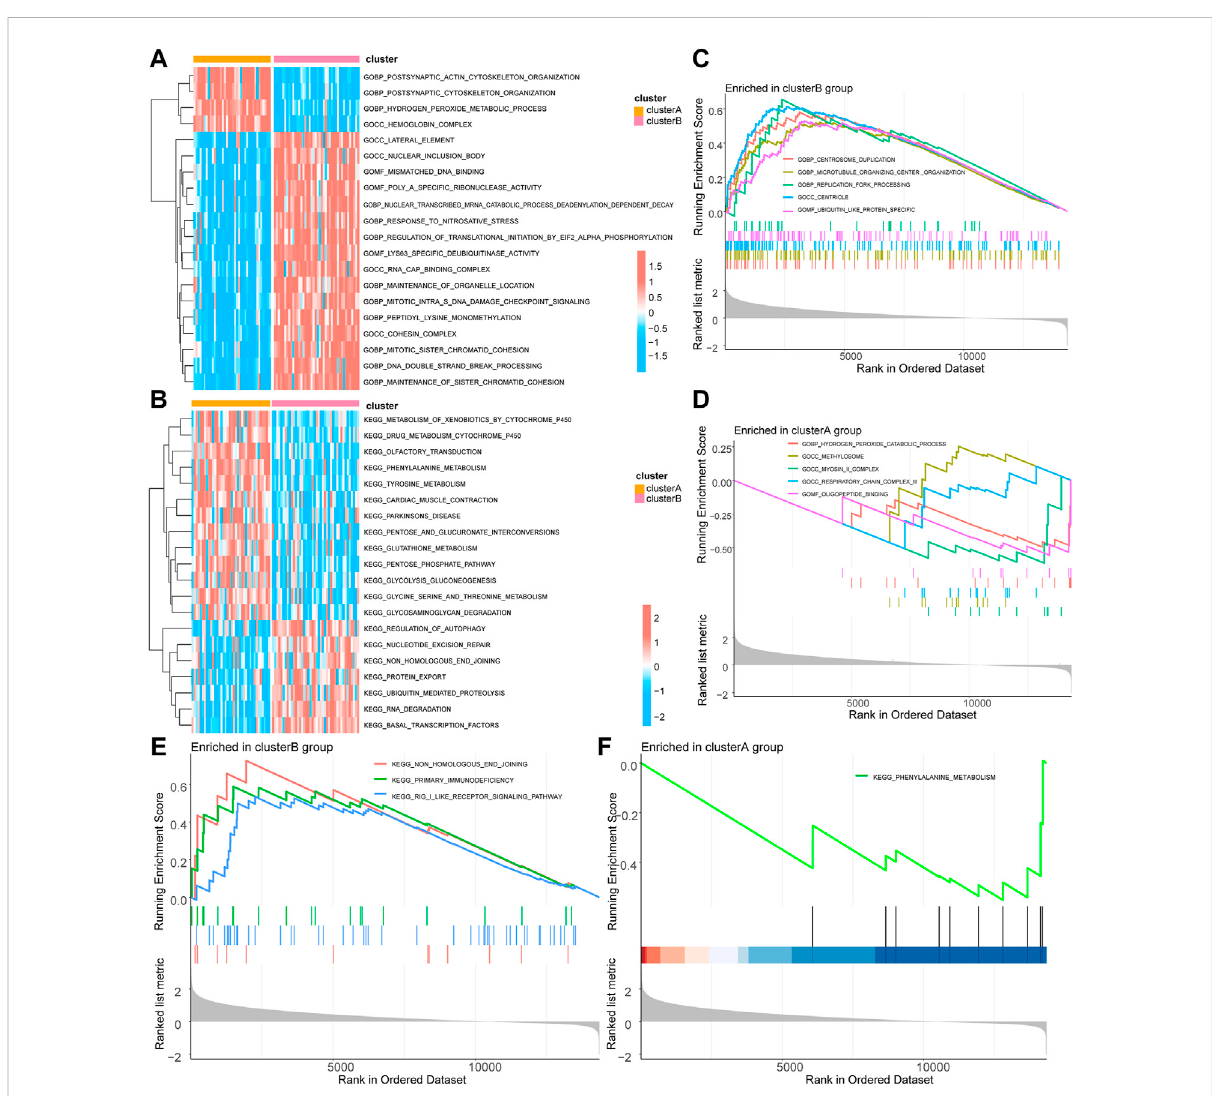
FIGURE 3 GSVA and GSEA of molecular subtypes of mitophagy-related genes. (A) GSVA-GO enrichment analysis heat map results based on the c5.go.v7.5.1.symbols gene set in different groups of the TCGA-UM dataset. (B) GSVA-KEGG enrichment analysis heat map results based on the c2.kegg.v7.5.1.symbols gene set in different groups of TCGA-UM dataset. (C) GSEA-GO cluster B enrichment analysis results pathway display. (D) GSEA-GO cluster A enrichment analysis results pathway display. (E) GSEA-KEGG cluster B enrichment analysis results pathway display. (F) GSEA-KEGG cluster A enrichment analysis results pathway display. GSVA, Gene Set Variation Analysis; TCGA, the cancer genome atlas; UM, uveal melanoma;GO,GeneOntology;KEGG,KyotoEncyclopediaofGenesandGenomes;GSEA,GeneSetEnrichmentAnalysis.Thescreeningcriteriafor signi fi cant enrichment in GSEA enrichment analysis was p <